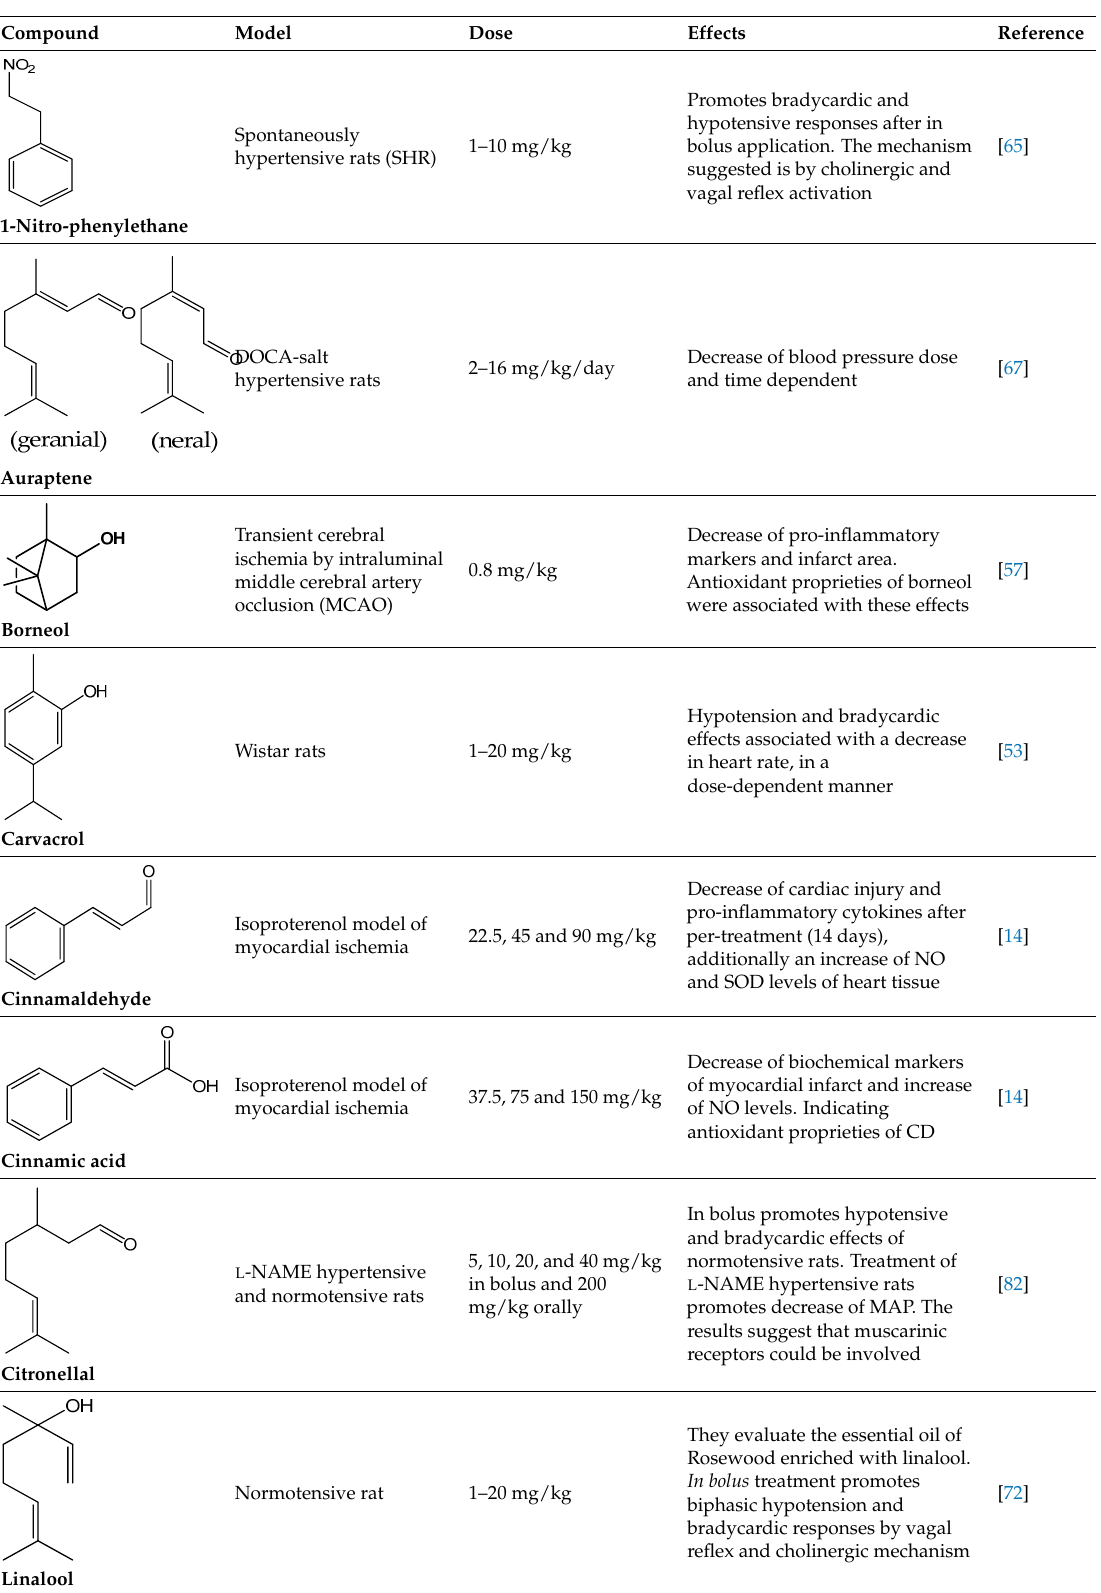
Table 2. In vivo cardiovascular effects of the chemical constituents of essential oils.